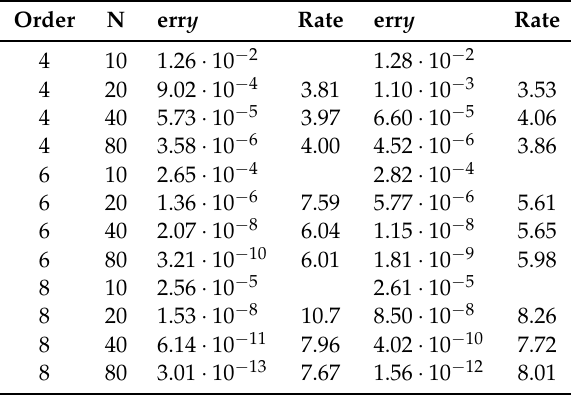
Table 4. Nonlinear pendulum problem: Maximum absolute error of the numerical solution and its derivative computed for 10